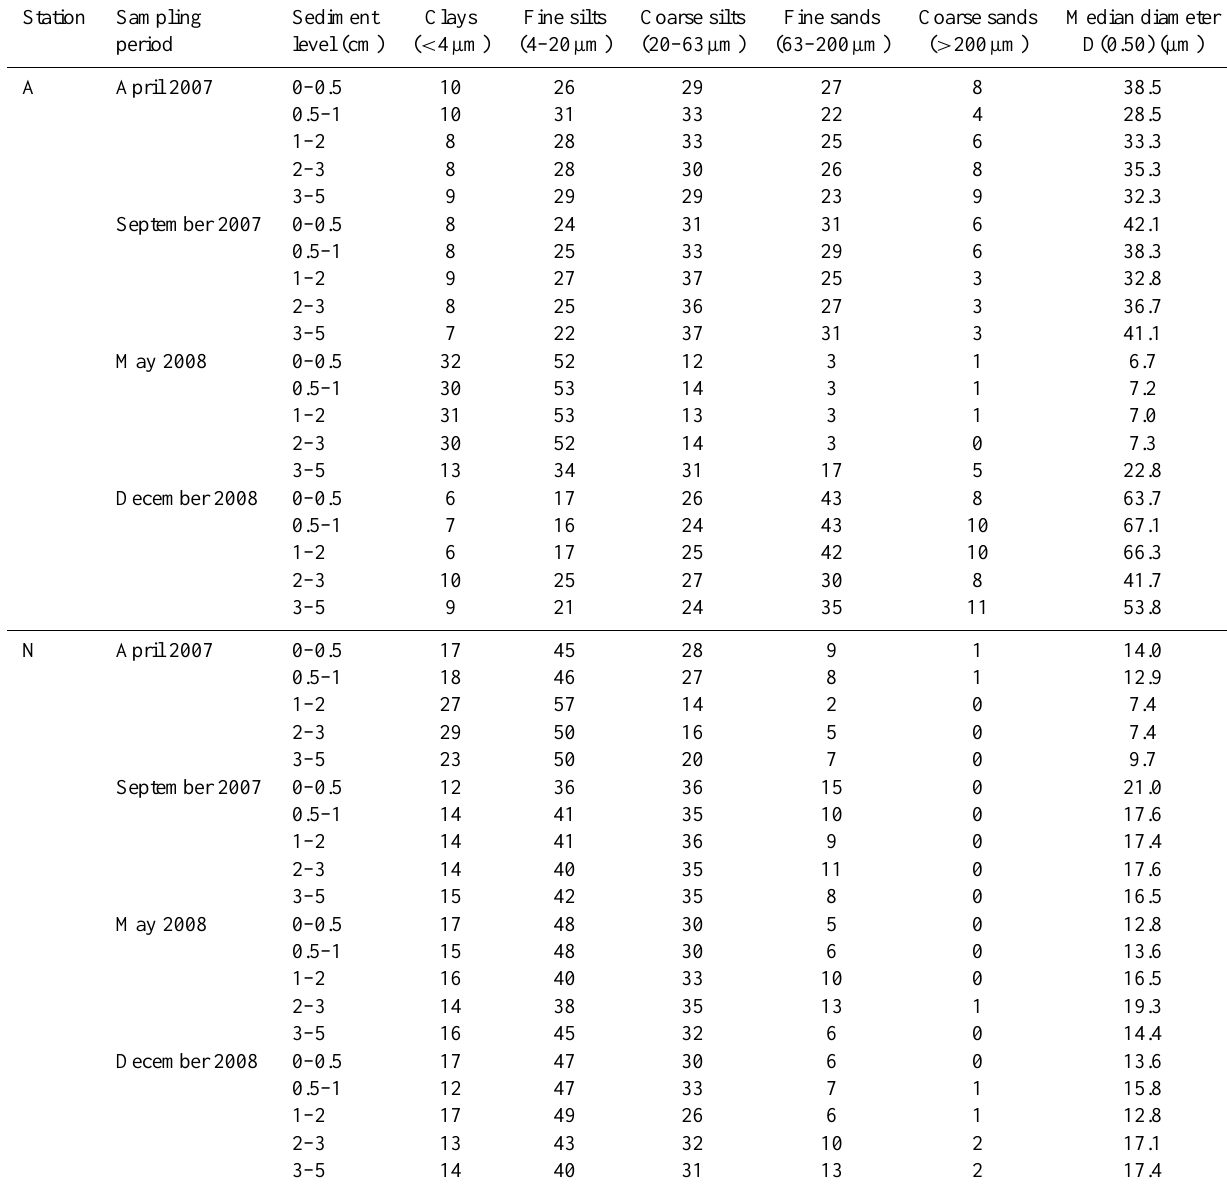
Table 2. Sediment grain size analyses performed in the top 5cm of the cores of both Stations A and N over the four sampling campaigns: percentages of clay, fine silts, coarse silts, fine sands and coarse sands, and sediment median diameter D(0.50) for each analysed sediment